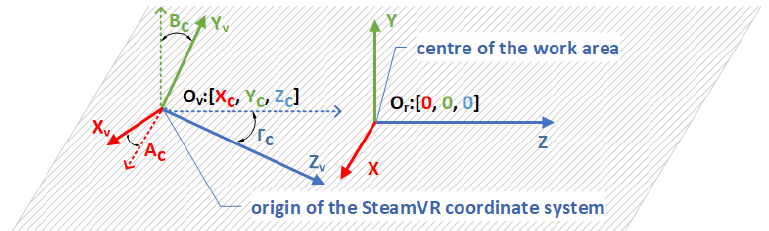
Figure 4. Translation and rotation between the real coordinate system and the SteamVR system. The hatched area represents the floor.